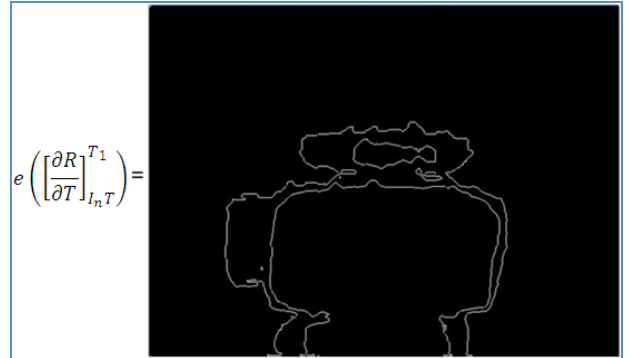
Figure 12. Temperature affected area at the primary tolerance level